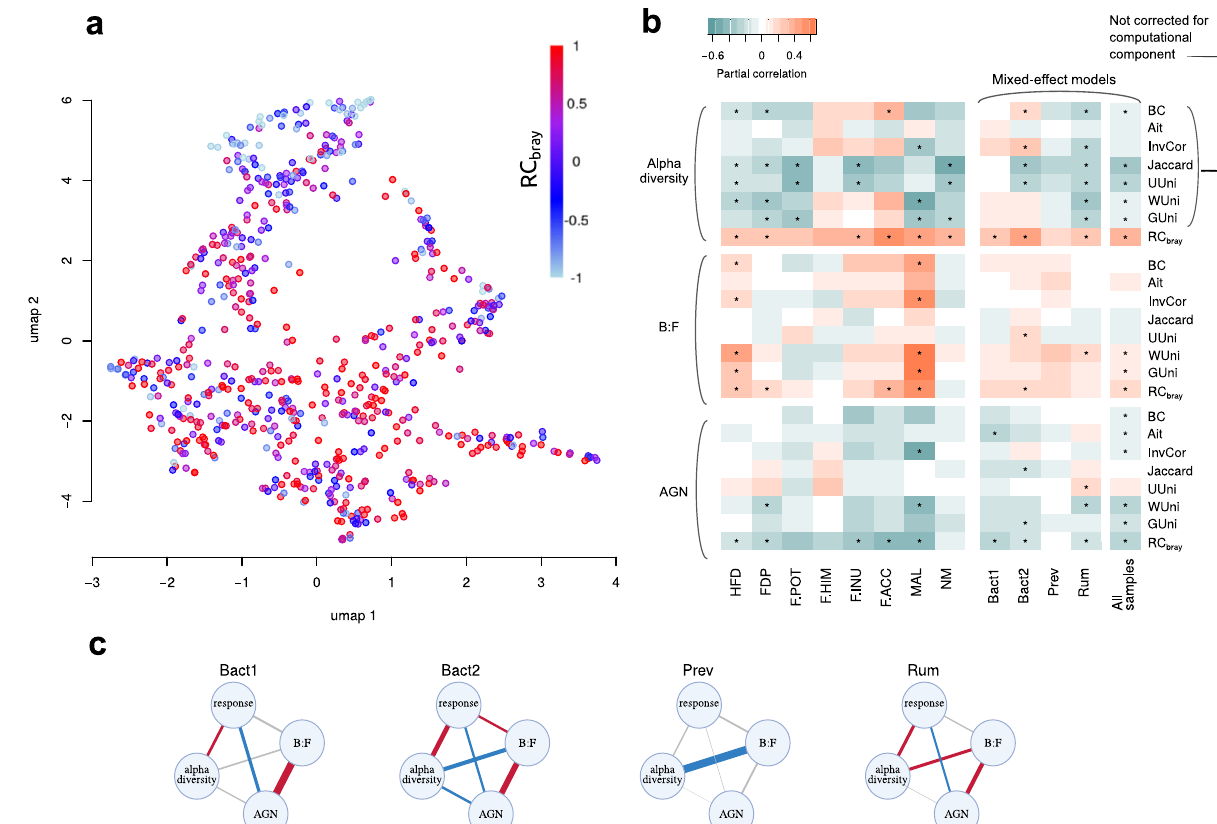
Fig. 3 Associations between microbiome response to interventions and baseline microbiome composition. a Distribution of baseline samples in the species abundance space coloured in the value of response - RC bray between samples before and after the intervention (UMAP algorithm). b Seven alternative beta diversity metrics were used for the response calculation: Bray – Curtis (BC), Aitchison (Ait), generalised UniFrac (GUni), weighted UniFrac (WUni), unweighted UniFrac (UUni), Jaccard and inverse Pearson correlation (InvCor). Colours denote partial correlation coef fi cients between the response and each of the analysed features. Asterisks denote signi fi cant associations (partial correlations, FDR < 0.05). Inconsistency for associations with alpha diversity between response metrics had been expected due to the computational component. c Enterotype-wise partial correlation networks between the response, baseline alpha diversity, AGN and B:F. The edges width is proportional to the absolute correlation coef fi cient. Blue colour denotes signi fi cant negative associations, red - signi fi cant positive and white – insigni fi cant (signi fi cance estimated using partial correlations, FDR < ratio (B:F) and mean number of genes per organism in the community (AGN, average gene number) - were analysed using partial correlation network due to potential correlations between the predictors (correlation between two components are com- puted with the correction for all the others, with intervention used as a random effect, see Methods). Baseline AGN was negatively associated with the response, while alpha diversity and B:F - positively (partial correlations, FDR < 0.05). The same effects were observed for most of the interventions analysed separately (partial correlations, FDR < 0.05, Fig. 3b). Enterotype strati fi cation showed that associations of AGN and alpha diversity with the response were observed in each enterotype except for the Prev (partial correlations, FDR < 0.05, Fig. 3b, c); association with the B:F ratio was detected only in the Bact2 enterotype (partial correlations, FDR < 0.05, Fig. 3b, c). Since partial correlation networks include a correction for alpha diversity, we were able to validate the results for B:F and AGN using seven other beta diversity metrics for response calculation (Bray – Curtis, Aitchison, generalised UniFrac, weighted UniFrac, unweighted UniFrac, Jaccard and inverse Pearson correlation) (Fig. 3b). According to the analysis type including all samples the most reproducible was negative association with AGN (observed for all fi ve weighted metrics), while positive association with B:F ratio was reproduced using three metrics.